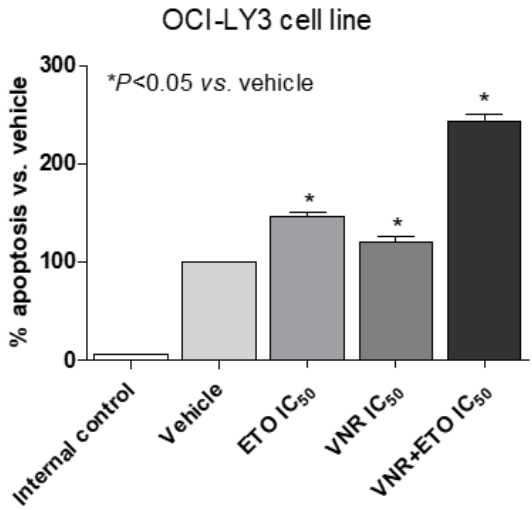
Figure 2. Apoptosis measurements using the Cell Death Detection ELISA Plus kit after 48 h of treatment. Absorbance values are representative of vehicle-treated and metronomic VNR, metronomic ETO and their combination cell cytosolic nucleosomes. All the absorbance values were plotted as a percentage of apoptosis relative to vehicle-treated cells which is labelled as 100%. The internal negative control was provided by the ELISA kit. Columns and bars, mean values ± SD, respectively. * p < 0.05 vs. vehicle-treated controls.